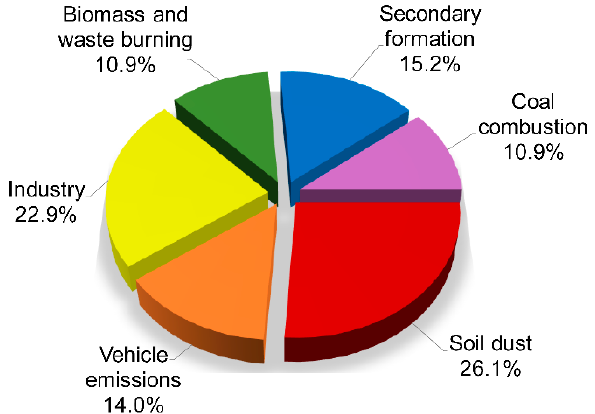
Figure 6. Contribution of each source to the PM2.5.